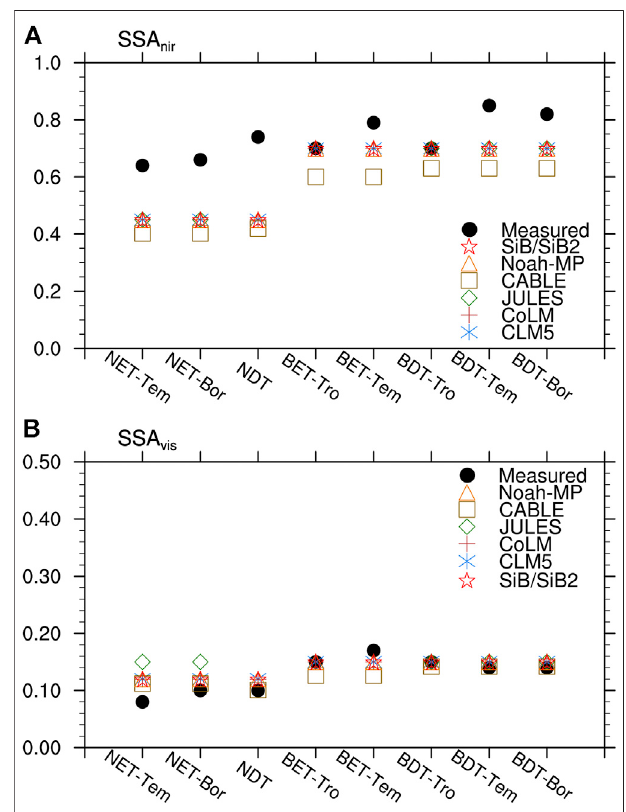
FIGURE 1 | Comparison of measured LOP values in the NIR band (A) and VIS band (B) with prescribed values in the different